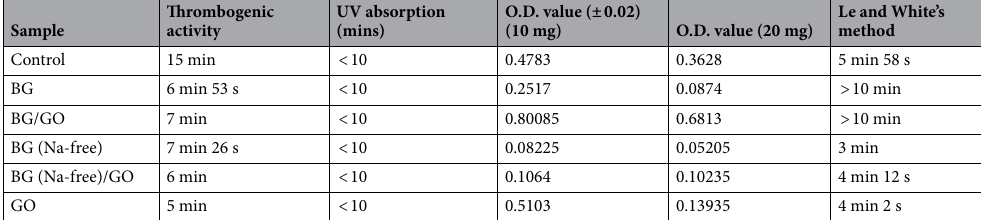
Table 1. Hemoclot assay of BG, BG (Na-free), GO and BG/GO, BG (Na-free)/GO nanocomposites using UV absorption technique and the Le and White method.